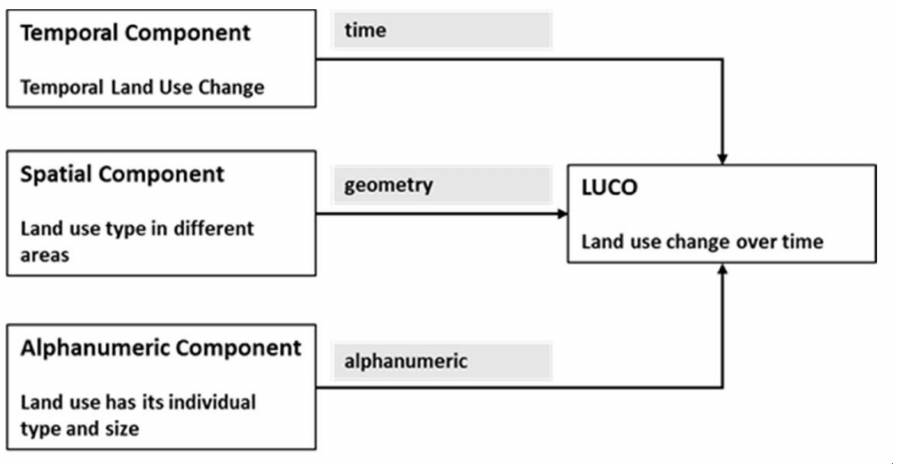
Figure 4. Mechanisms and components of the LUCO